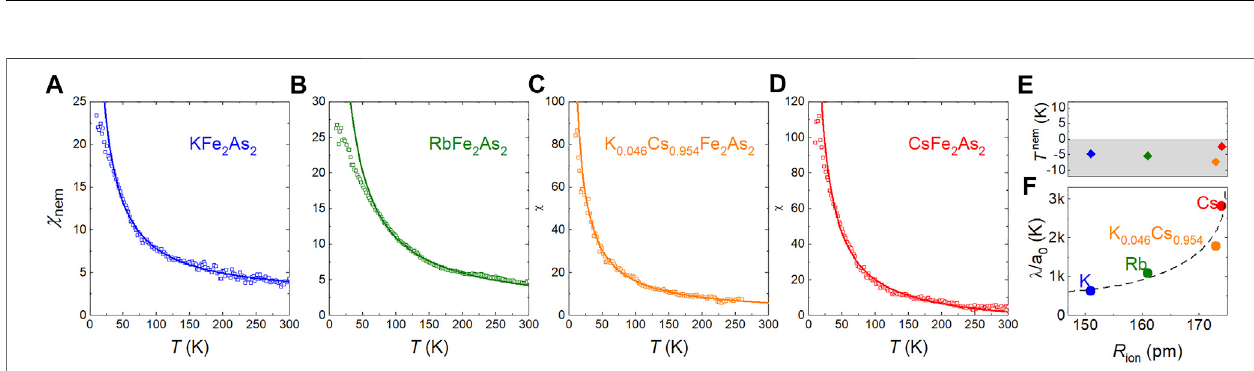
FIGURE 1 | Representative example of elastoresistance under strain for KFe piezo actuator at a fi xed temperature T = 50 K. The strain was applied along the [110] direction. (B) Change of resistance Δ R / R as a function of strain Δ L / L at several temperatures.